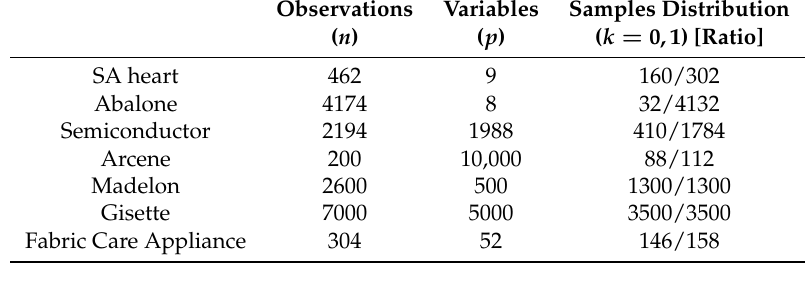
Table 1. Real datasets summary. The last column indicates the number of observations belonging to each of two classes. Madelon is an artificial dataset and included here among real data.